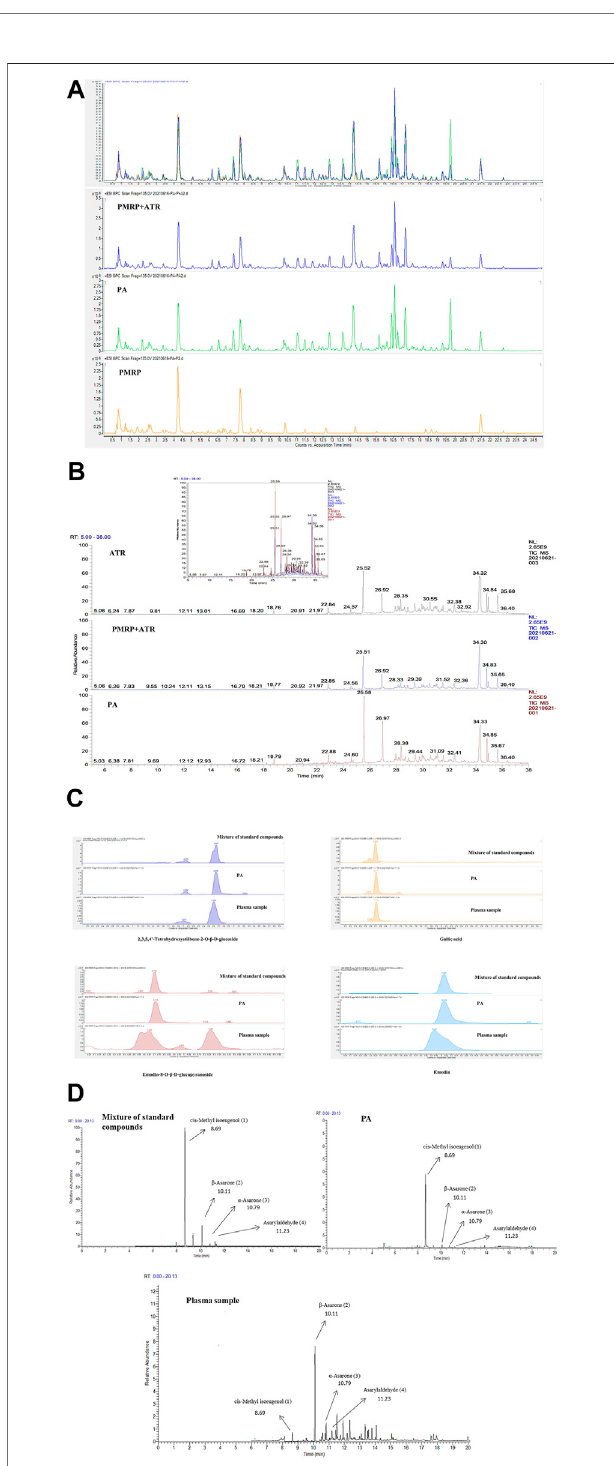
FIGURE 2 | Analysis of PA components.( A , C ) Components of PA analyzedbyHPLC-MS.( B , D )Components ofPAanalyzed byGC-MS. (1) cis - Methyl isoeugenol; (2) α -asarone; (3) β -asarone; and (4)